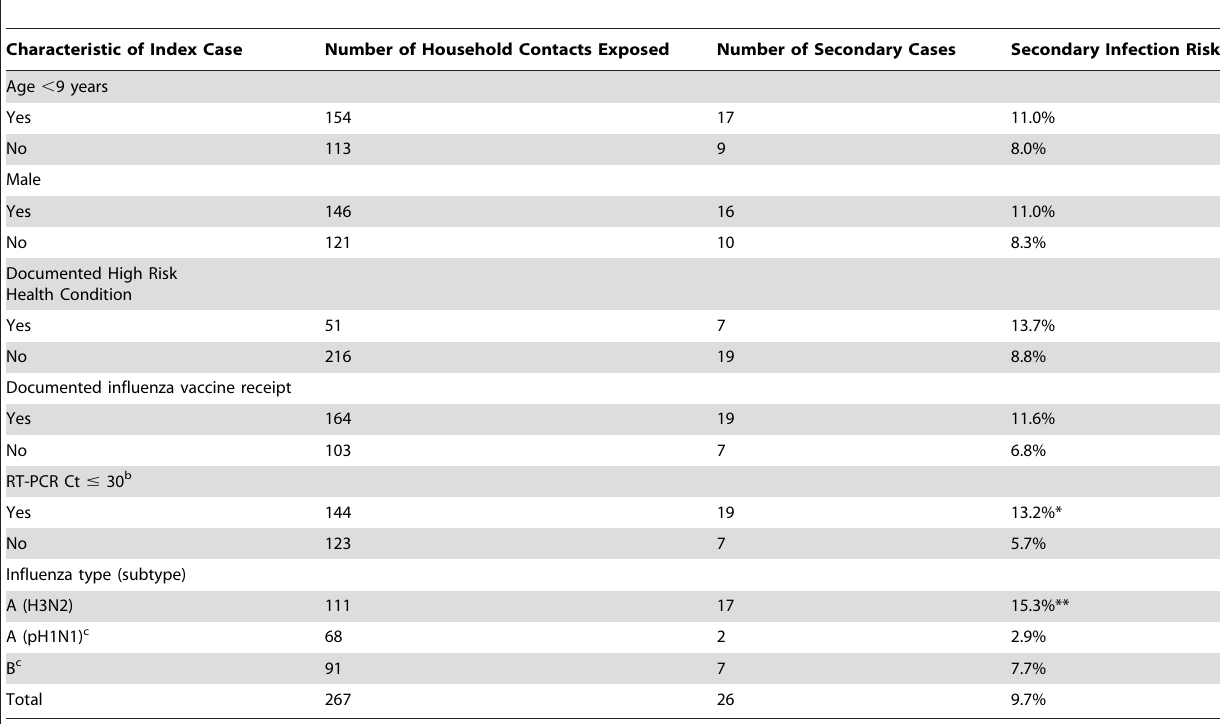
Table 3. Secondary infection risks by characteristics of household influenza index cases a : the Household Influenza Vaccine Effectiveness (HIVE) study, Ann Arbor Michigan, 2010-2011 influenza season.